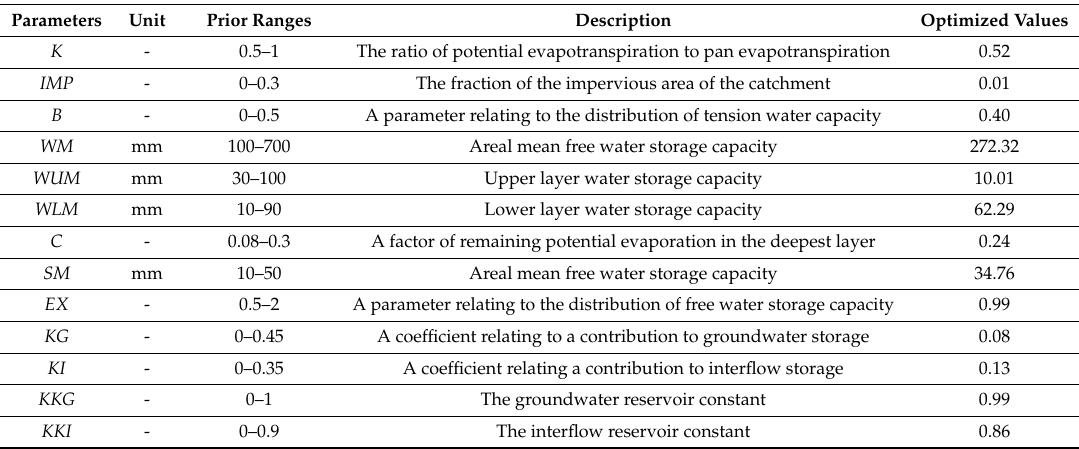
Table 2. Descriptions of the XAJ model parameters.